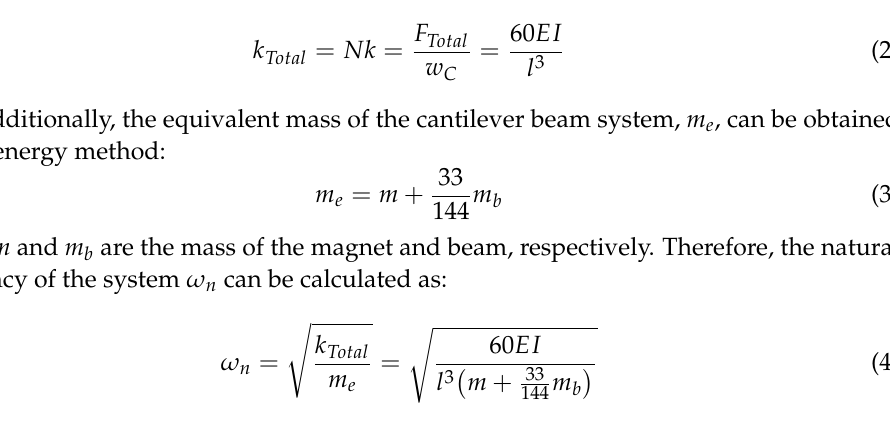
Figure 3. Schematic diagram of the SPEH model and colored pattern. ( a ) Fixed beam simplified model (cross-section of SPEH vibrator). ( b ) Fixed beam simplified model (single trapezoidal beam of SPEH vibrator). ( c ) Colored pattern of stress. ( d ) Colored pattern of displacement under external force.